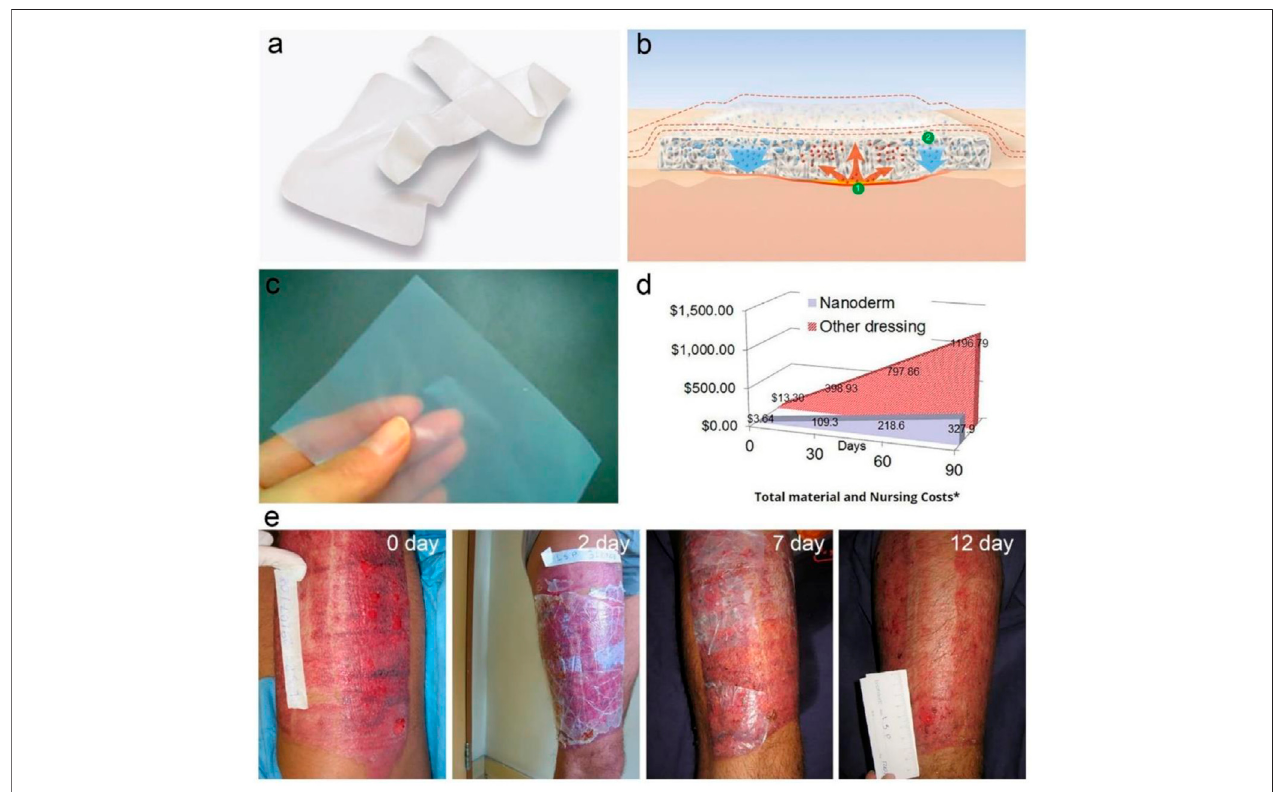
FIGURE 9 | Wound dressing made from BNC; (A) the wet wound dressing Suprasorb ® X is made up of 1.5 – 4.3% BNC and other balanced water, (B) demonstrationoftheabilityofSuprasorb ® Xwounddressingtoabsorbwoundexudateandtransportwatertoregionswithlowexudate. (C) NanodermTM,a fl exibleand transparentdrywounddressing. (D) ThetotalcostofNanodermTMwounddressingversustraditionalwounddressingintermsofmaterialsandcare. (E) Theskindonor locationisdressedwithNanodermTMwounddressing.Theinitialdonorlocation,aswellas2,7,and12 daysfollowingtherapy,areshowninthephotographsfrom left to right. Reprinted with permission from Zhong (2020) under Creative Commons Attribution License (CC BY).